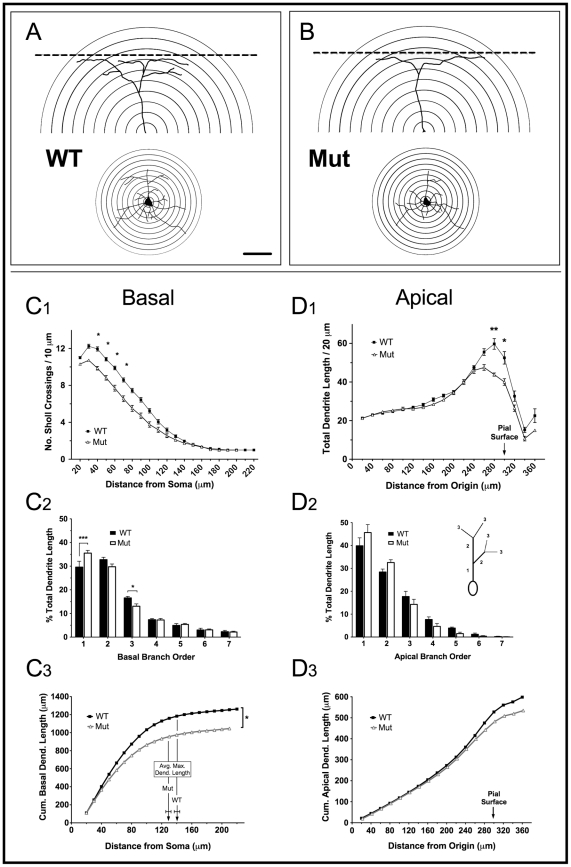
Dendritic branching and length is reduced in YFP+ MeCP2J mutant neurons.A, B) Reconstructions of representative WT and mutant YFP+ L5 pyramidal neurons based on the Sholl analysis branch patterns in C1 and D1. Scale bar (A) = 50 µm. C1) Basal compartment Sholl analysis showing the number of dendrite crossings as a function of distance from the soma. Mutant YFP+ neurons have significantly fewer dendritic branches 40–70 µm from the cell body. D1) Apical compartment Sholl analysis of the summed dendritic length per Sholl radius. Mutant YFP+ neurons have less total dendritic length per Sholl radius in L1–2. Dendrite lengths in radii greater than 300 µm correspond to long, laterally extending dendrites that are near and parallel to the pial surface. C2, D2) Percent dendritic length as a function of branch order in basal and apical compartments. The inset in (D2) shows branch order hierarchy. In basal dendrites only, mutant YFP+ neurons exhibit significantly reduced dendritic complexity with proportionally more dendritic length in lower branch orders. C3) A cumulative total length plot for basal dendrites shows that the main divergence in total dendritic length occurs less than ∼120 µm from the soma. The average maximum dendritic length is also reduced in mutant YFP+ neurons. D3) A cumulative total dendritic length plot of apical tuft branches shows no minimal divergence except close to the pial surface, where mutant YFP+ cells extend fewer lateral branches.